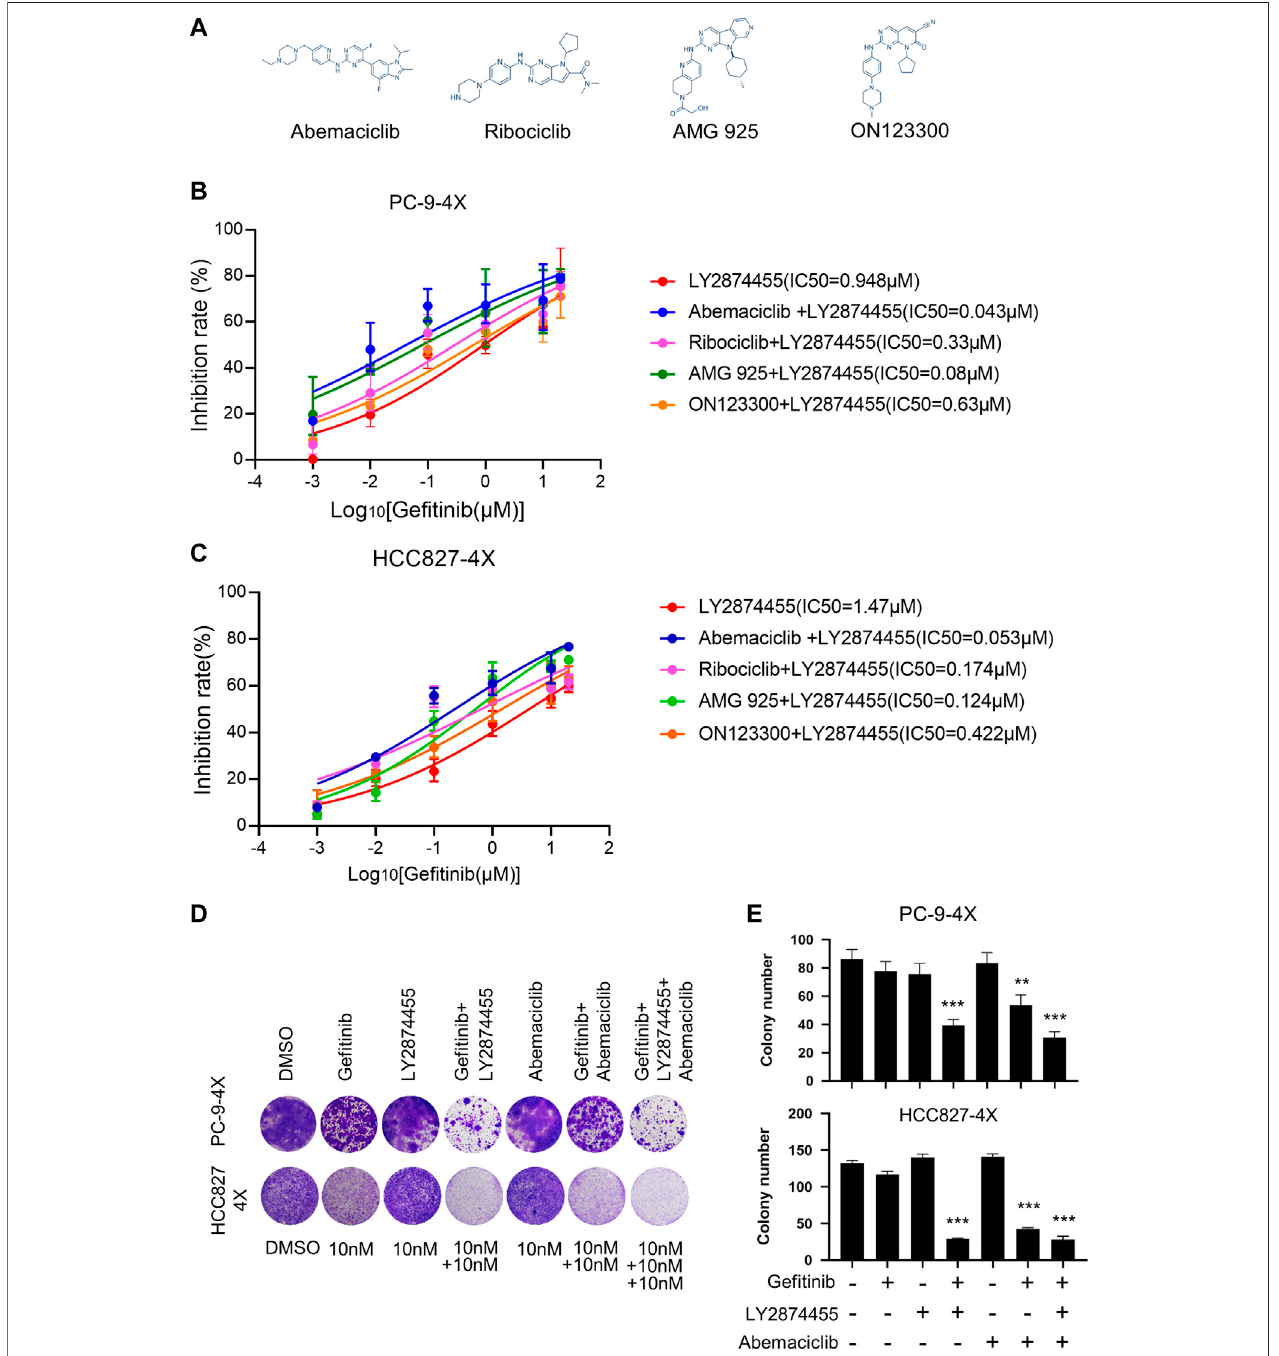
FIGURE 3 | The combination of ge fi tinib/LY2874455/abemaciclib reverses the ge fi tinib resistance induced by FGFs/CCND1 in vitro. (A) The structural formulae of inhibitors target to CDK4/CCND1 complex. (B) PC-9-4X Cells were treated with LY2874455 and ge fi tinib in combination with different CDK4 inhibitors for 72 h to measure the inhibition rate by CCK8. Error bars represented SD. (C) HCC827-4X cells were treated with LY2874455 and ge fi tinib in combination with different CDK4 inhibitorsfor72 htomeasureinhibitionratebyCCK8.ErrorbarsrepresentedSD. (D) CrystalvioletstainingofPC-9-4XorHCC827-4Xcelllinesaftertreatmentwith DMSOortheindicateddrugsfor14 days. (E) Thenumberofstainedcellsincrystalvioletstainingin (D) .Errorbarsrepresented SD( p -valuesre fl ectedcomparisontothe control samples. * p < 0.05. ** p < 0.01. *** p < 0.001, one-way ANOVA, with Tukey ’ s test).